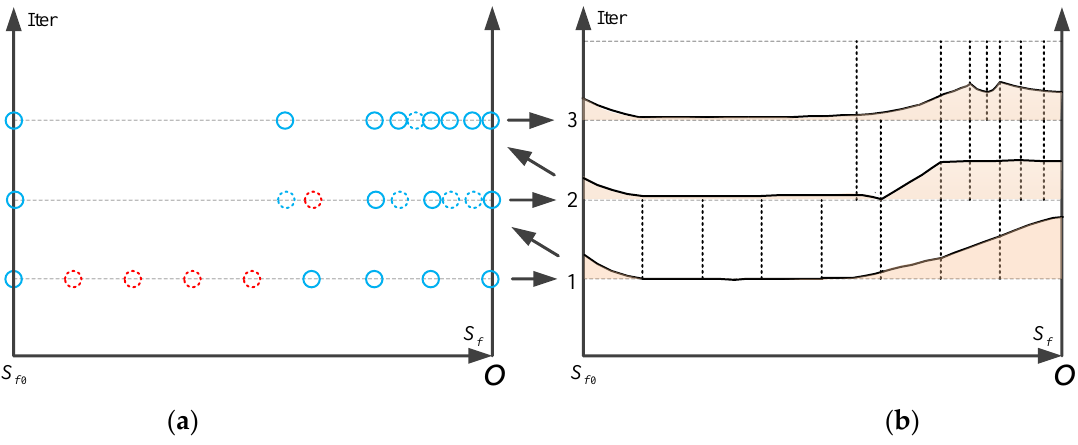
Figure 4. Grid points adjustment method: ( a ) represents the location of grid points; ( b ) represents the distribution of the probability density function distribution of grid points.